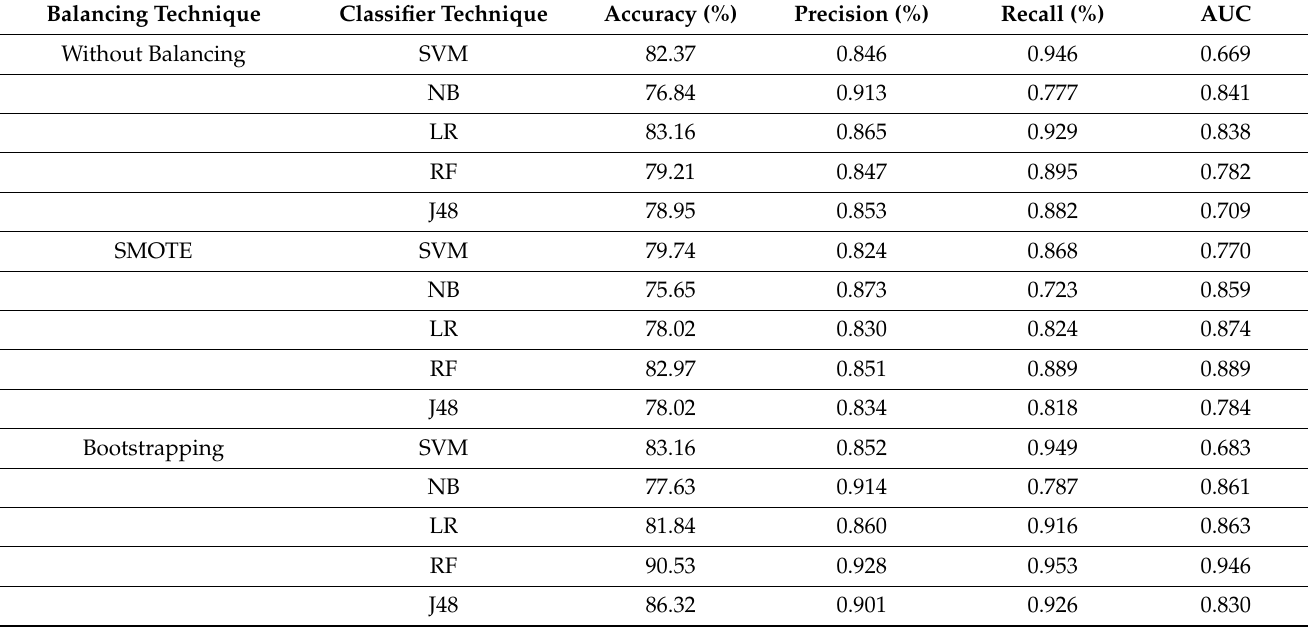
Table 5. Performance of the classifiers using the correlation